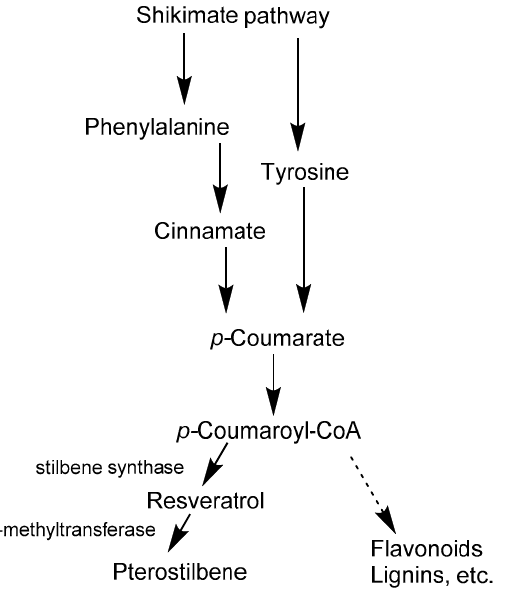
Figure 2. Biosynthetic pathway for resveratrol and pterostilbene and its relationship to other sec- ondary products of the shikimate pathway.